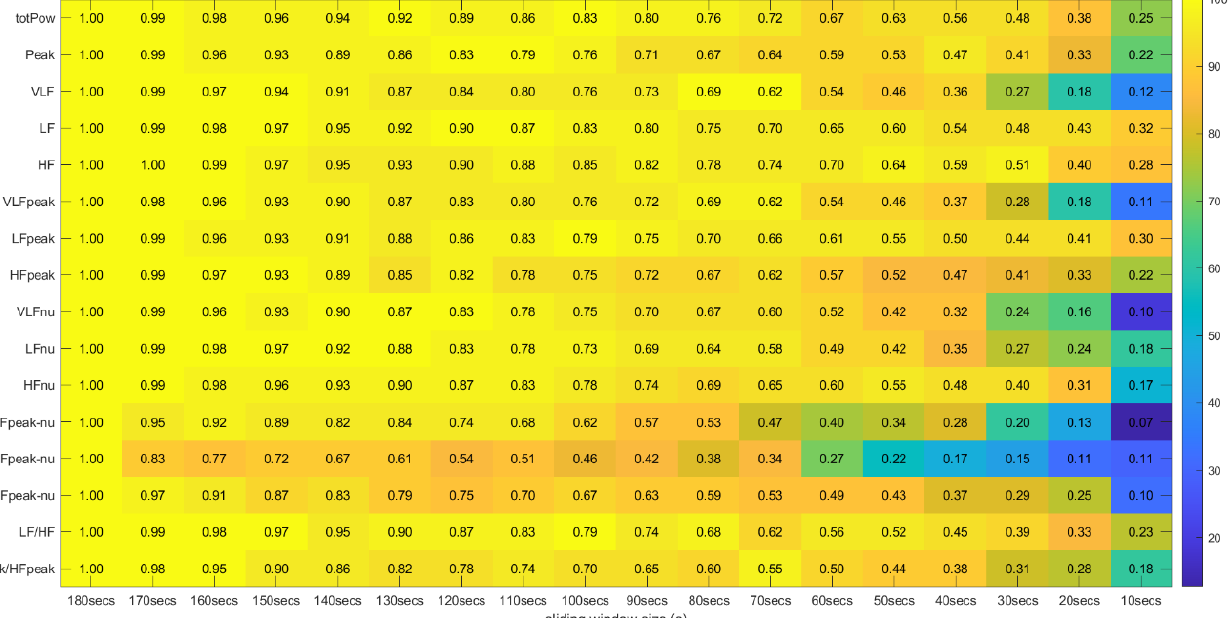
Figure 10. Spearman’s Correlation Test (Time, Non-Linear and Geometrical Domains) ** Heatmap Colors: Percentage of runs where there exists significant correlation between the feature (row) extracted using the respective window size (column) and the same feature obtained using the 180-second sliding window. Cell Values: Means, across the different runs, of the correlation coefficients between the feature (row) extracted using the respective window size (column) and the same feature obtained using the 180-second sliding window.